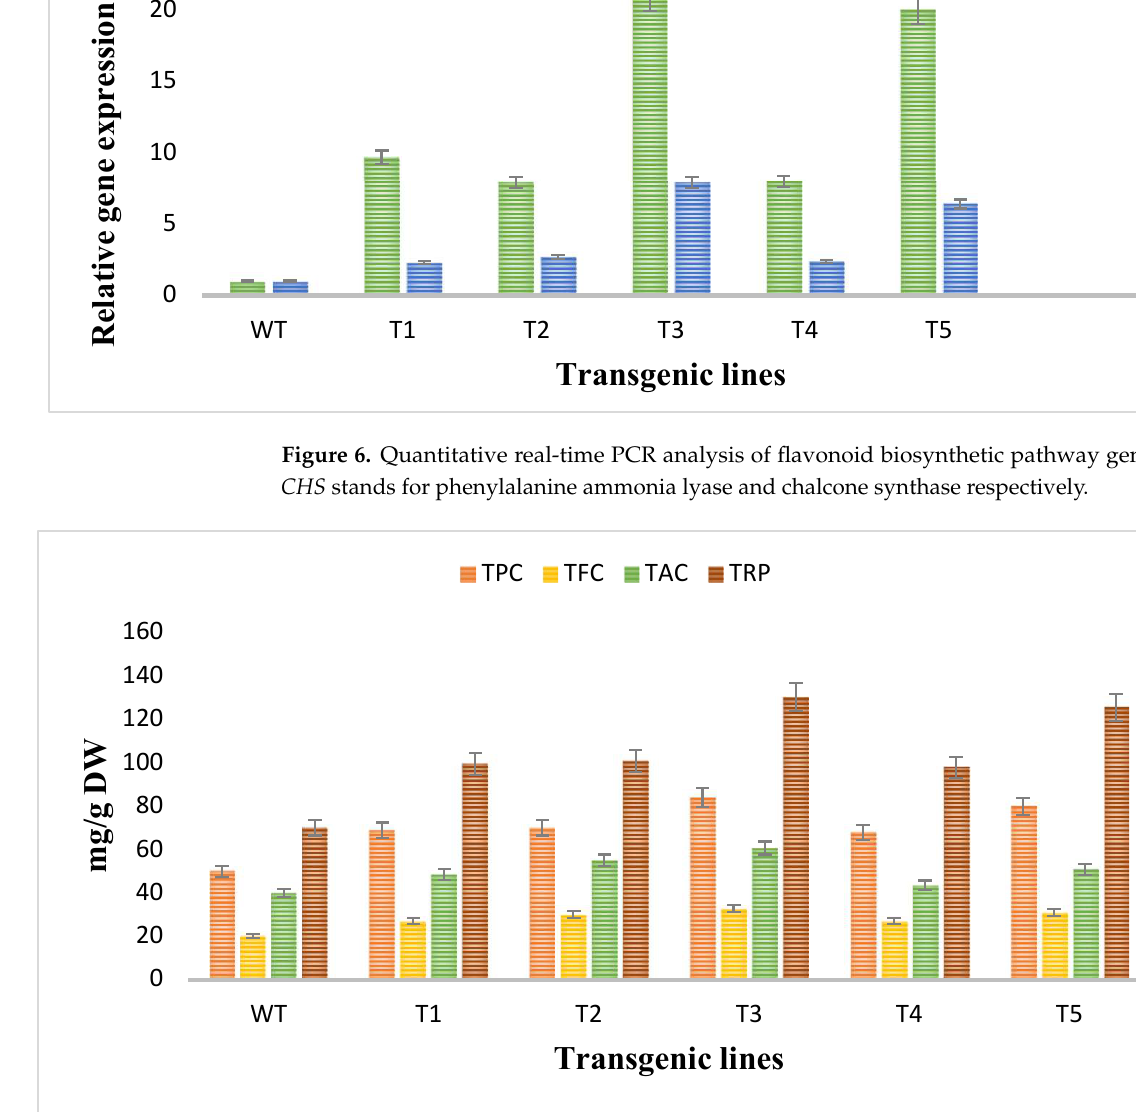
Figure 7. Evaluation of antioxidant potent through different antioxidant assays. TPC (total pheno- lic content, TFC (total flavonoid content), TAC (total antioxidant capacity), and TRP (total reduc- ing